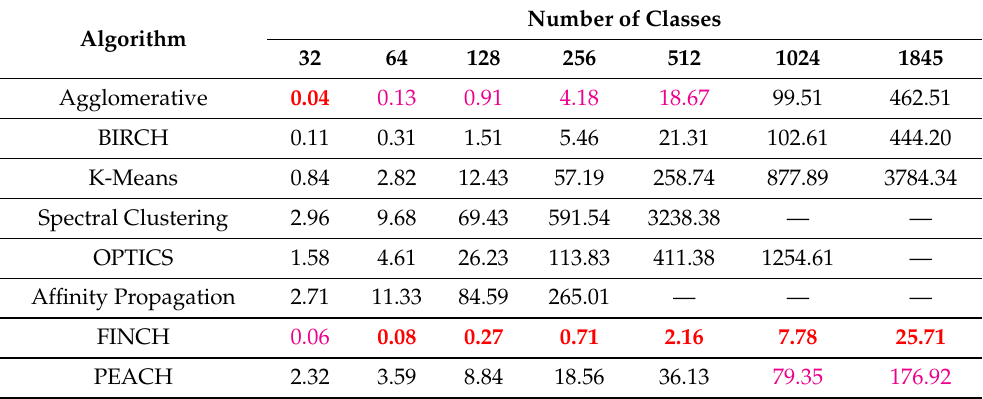
Table 6. Running Time of IJB-B Protocols. Running time in seconds for various clustering algorithms is provided for all IJB-B protocols. Missing values (—) indicate that results could not be obtained within one day. We mark the second-fastest and fastest algorithms